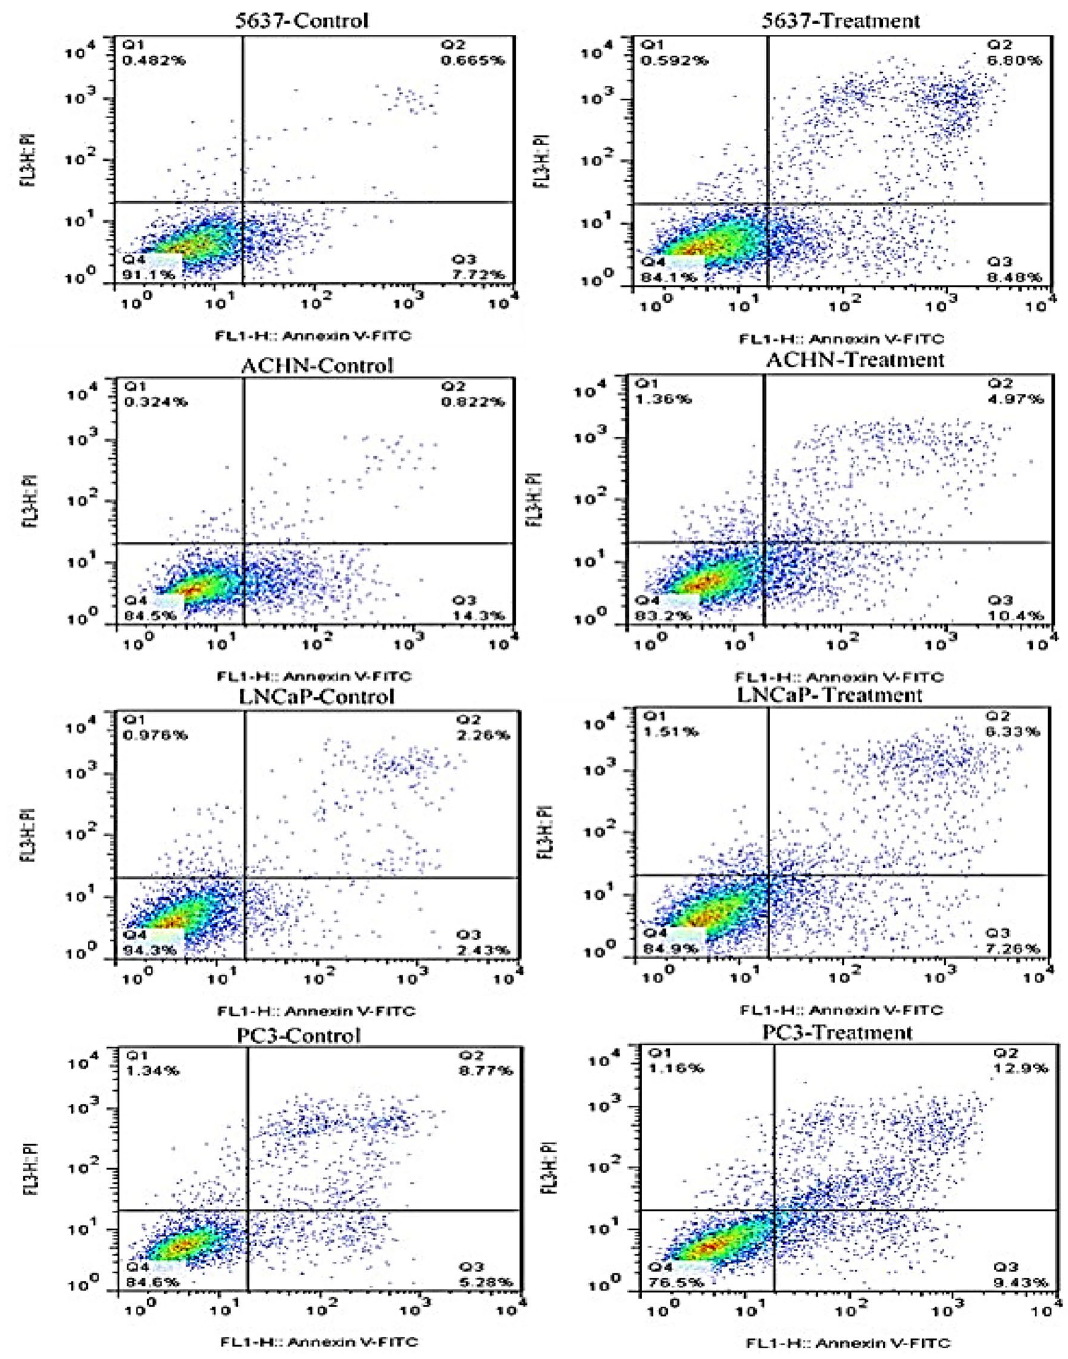
Figure 5. Flow cytometric analysis of LNCaP, PC3, ACHN, and 5637 cells apoptosis using Annexin-V- Flous. The lower left quadrant shows live cells, the lower right quadrant shows early apoptotic cells, the upper right quadrant shows late apoptotic cells, and the upper left quadrant shows necrotic cells. Results regarding induced apoptosis of PC3, LNCaP, 5637 and ACHN cancer cells untreated and treated with Exosome. Statistical significance was defined at * P < 0.05, ** P < 0.01, and *** P < 0.001 compared to the corresponding